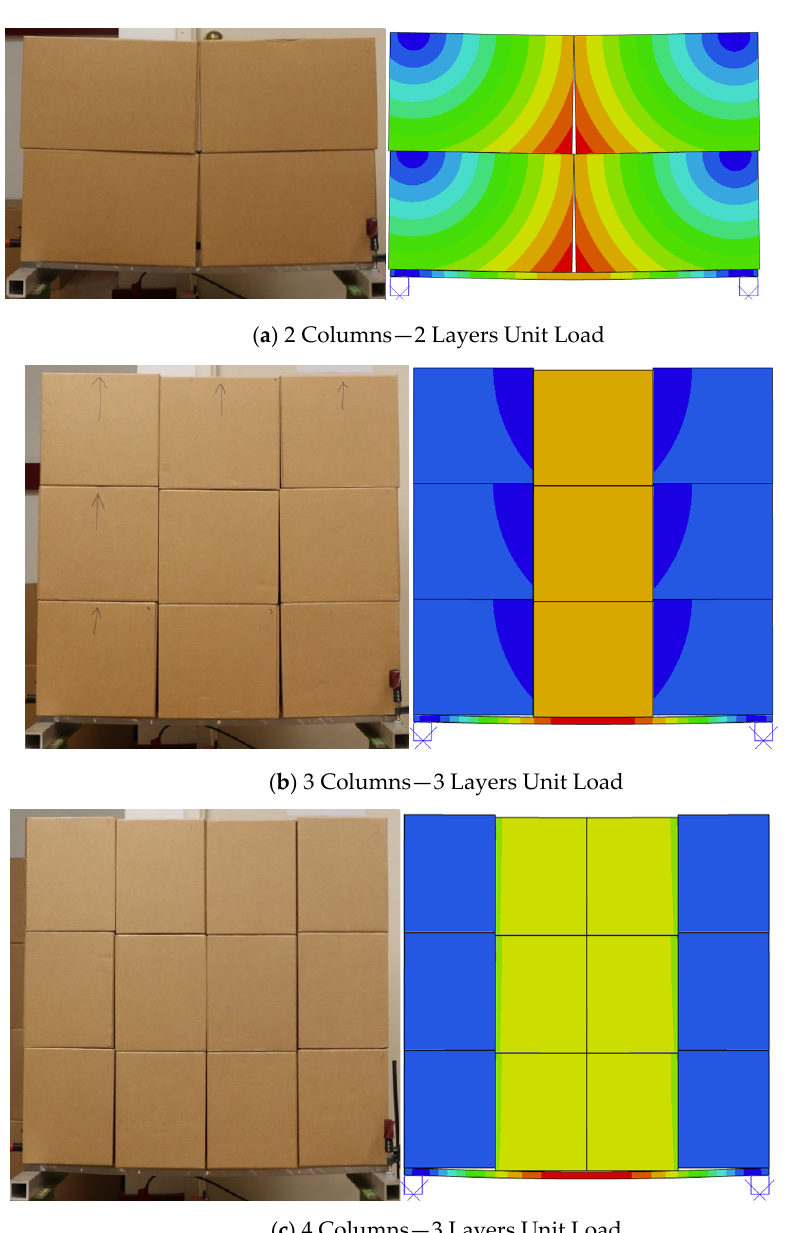
Figure 10. Comparison of movement of unit load components under deflection for experimental ( left ) and finite element analysis ( right ) for two layers and ( a ) two columns, ( b ) three columns, and ( c ) four columns of packages. Images shown for the model ( left ) are colored based on deflection. Red equals large displacements, blue represents no movement.